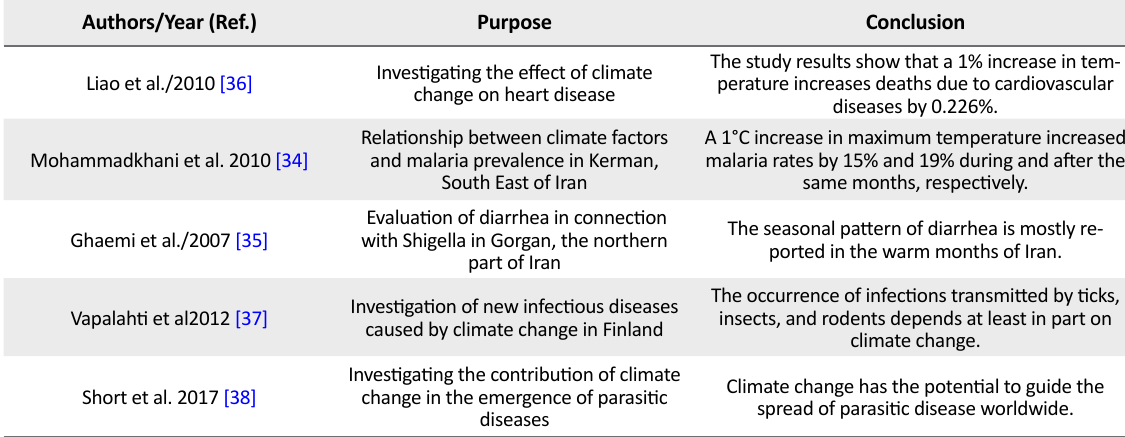
Table 1. Summary of evidence for diseases related to climate change Authors/Year (Ref.)